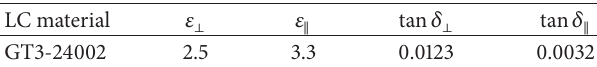
Table 1: Dielectric properties of the chosen LC material at 1–10GHz and 23 ∘